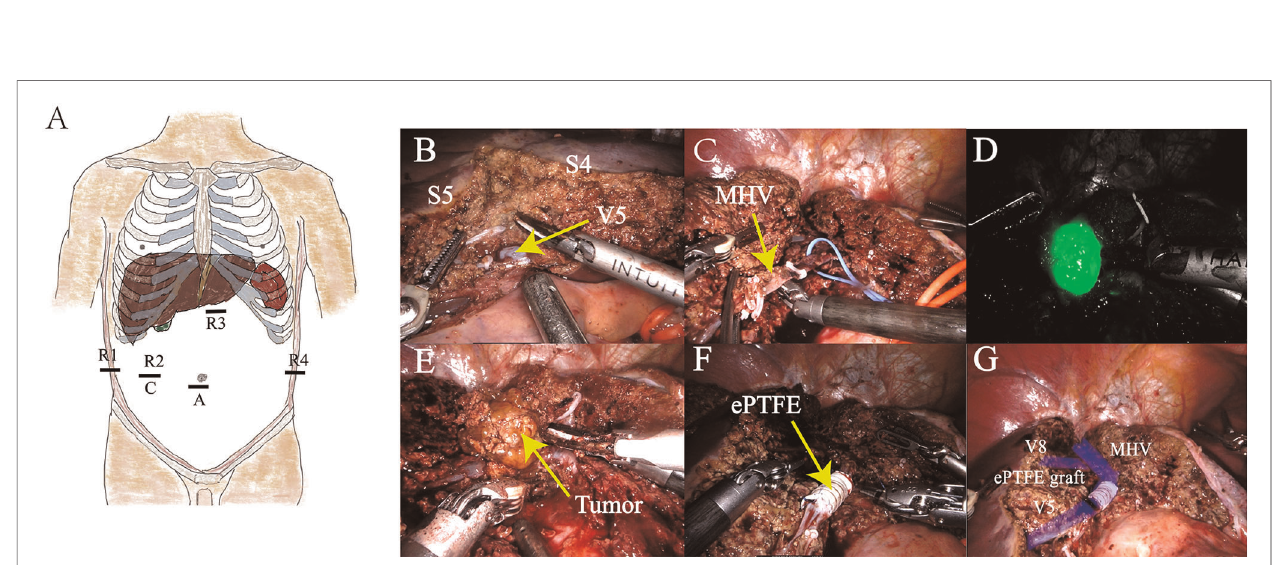
FIGURE 2 | ( A ) Human distribution position of Xi trocar. ( B ) S4 and S5 segments were isolated, revealing the V5 branch of the MHV. ( C ) Trunk of the MHV was cut. ( D ) Intraoperative fl uorescence imaging of the tumor was performed to facilitate complete resection of the tumor. ( E ) Isolation and resection of tumors. ( F ) MHV reconstruction using arti fi cial blood vessels of expanded polytetra fl uoroethylene material. ( G ) Schematic of the completion of MHV reconstitution.